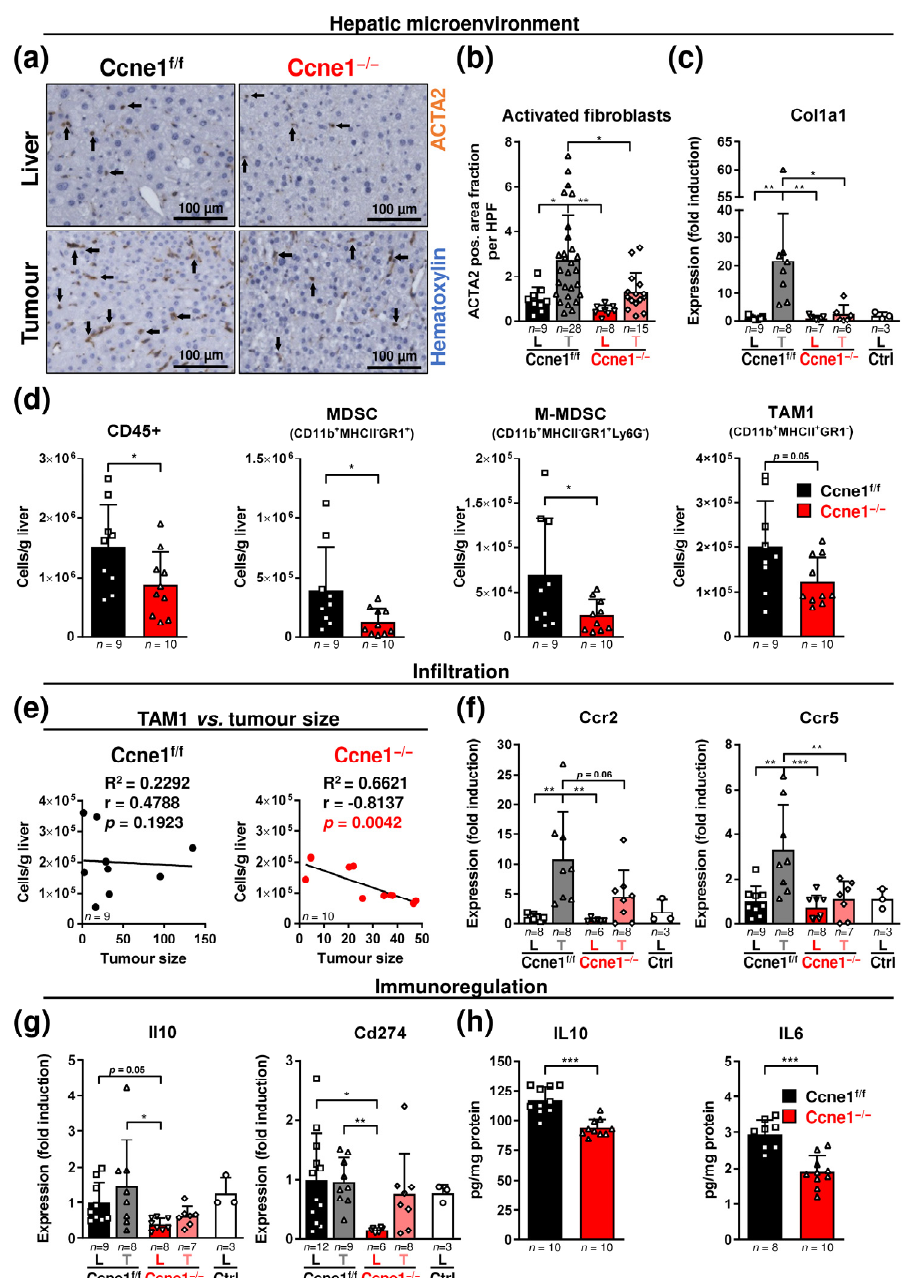
Figure 5. Interventional deletion of Ccne1 is associated with reduced presence of activated myofibroblasts and myeloid cells during HCC progression. Two-week-old Mx-Cre transgenic mice with floxed Ccne1 allele were treated with DEN. After tumour initiation, mice were repetitively injected with pIpC at week 22 to induce the deletion of Ccne1 (Ccne1 − / − ). Mx-Cre -negative mice also received both DEN and pIpC and served as wildtype controls (Ccne1 f/f ). HCC progression was analysed after week 40. Details are given in Figure 1 and in the method section. L: liver; T: tumour tissue. ( a ) Immunohistochemical smooth muscle actin alpha 2 (ACTA2) staining (brown) of paraffin sections in tumour-free liver and tumorous tissues. Total nuclei were stained with hematoxylin (blue). Arrows indicate ACTA2-positive cells. ( b ) Quantification of ACTA2-positive area fraction at a magnification of 200×. HPF: High power field. ( c ) Gene expression analysis of collagen type I alpha-1 chain ( Col1a1 ). Ctrl: livers of untreated wildtype mice. Normalised expression levels were calculated as fold induction in comparison to DEN-treated control livers. ( d ) Determination of immune cell populations according to surface marker expression, cluster of differentiation 45 (CD45)-positive cells, myeloid-derived suppressor cells (MDSC), monocytic MDSCs (M-MDSC), granulocytic MDSCs (G-MDSC), tumour-associated macrophages 1 (TAM1), as cells per gram liver by cytometry. The gating strategy is shown in Figure S2a and described in the method section. Data are expressed as mean ± SD. ( e ) Linear analysis. Correlation between the cumulative tumour size and amount of TAM1. R 2 : Coefficient of determination, r: Pearson correlation coefficient, p -values are indicated within diagrams. ( f , g ) Gene expression analysis of